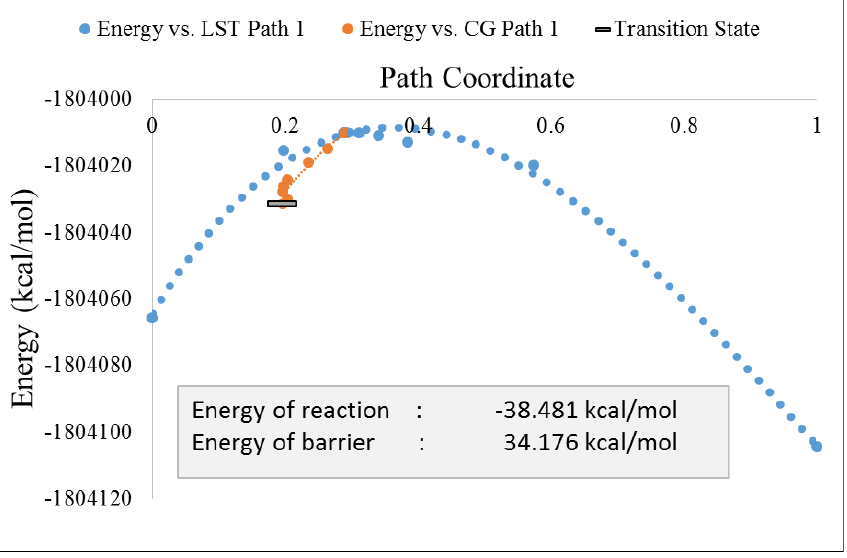
Figure 7: BDEs computed in: vacuum and water (COSMO) for the bonding of phenyl- radicals on 3 distinctive grafting position onto Graphyne surface.